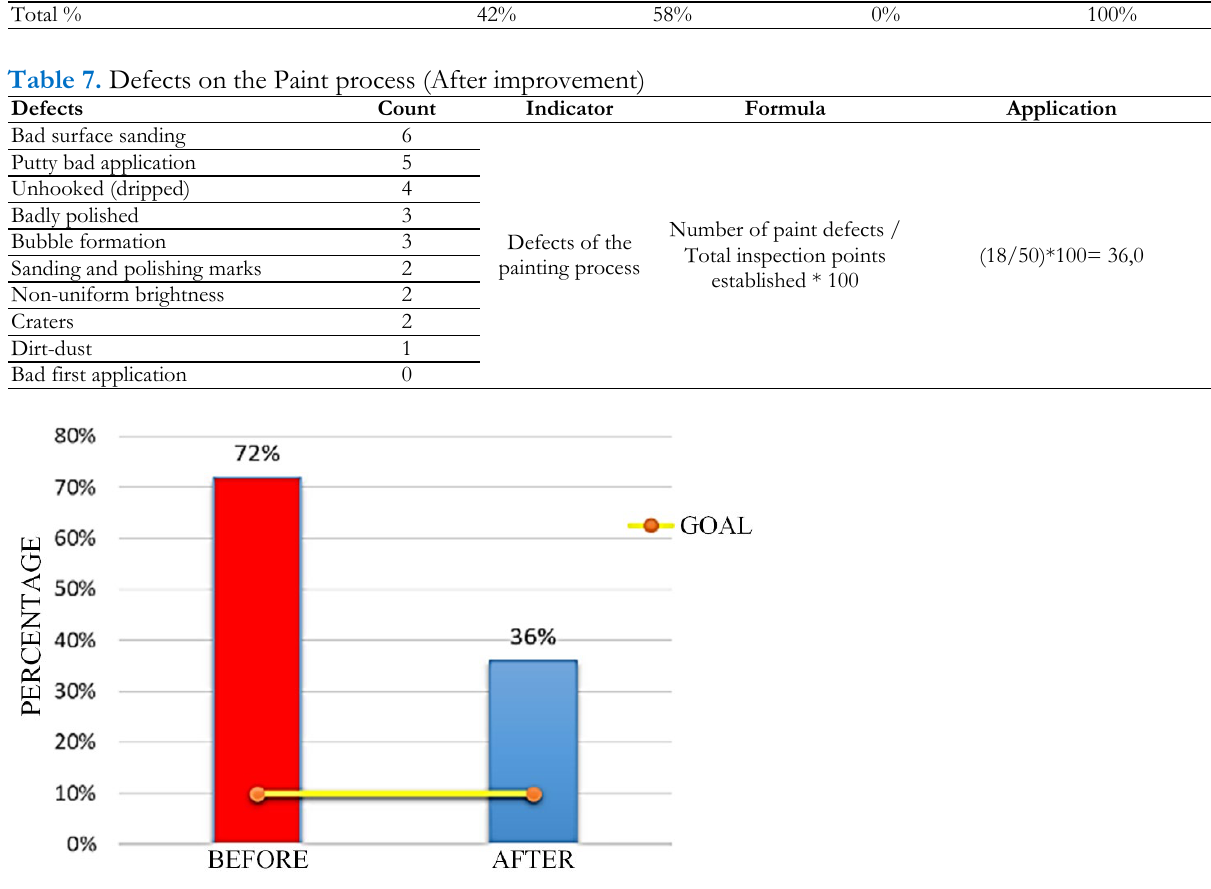
Figure 5. Defects on the Paint process (Before and